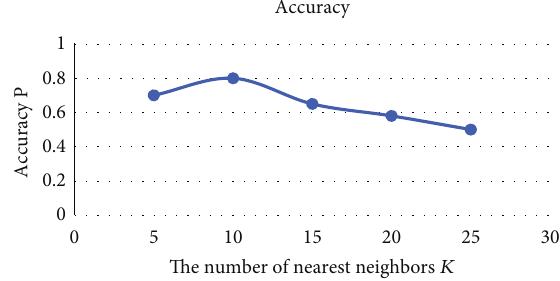
Figure 2: Accuracy of learning resource recommendation results.